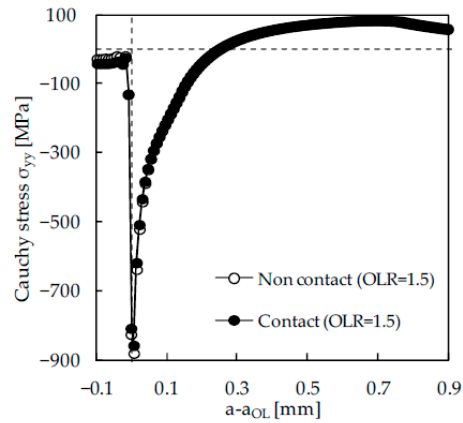
Figure 12. Effect of an overload on da/dN . ( a ) With contact of crack flanks. ( b ) Without contact of crack flanks ( F max = 41.67 N; F min = 4.17 N; F OL = 60.42 N; Δ K BL = 10.3 MPa·m 0.5 ; OLR = 1.5).